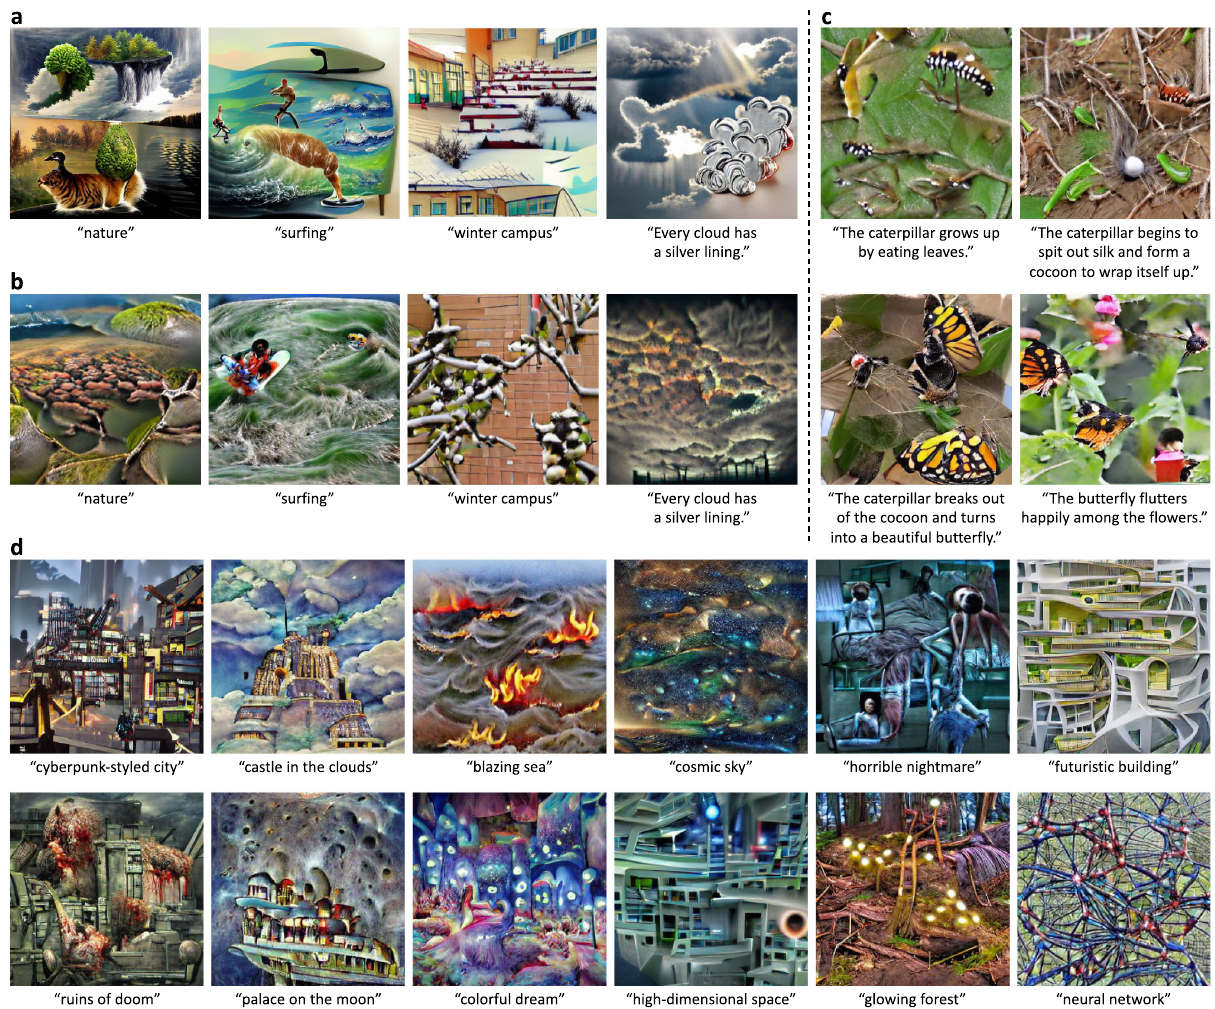
Fig. 3 Text-to-image generation examples of clearer imagination. a Generation examples of VQGAN inversion with CLIP (w/ ResNet-50x4). b Generation examples of VQGAN inversion with our BriVL. c A series of generation examples by VQGAN inversion with our BriVL. d More generation examples by VQGAN inversion with our BriVL, where concepts/scenes are rarely seen by us humans (e.g., “ blazing sea ” and “ glowing forest ” ) or even do not exist in real life (e.g., “ cyberpunk-styled city ” and “ castle in the clouds ” ). Note that VQGAN is pre-trained on ILSVRC-2012. BriVL, CLIP and VQGAN are all frozen during text-to-image